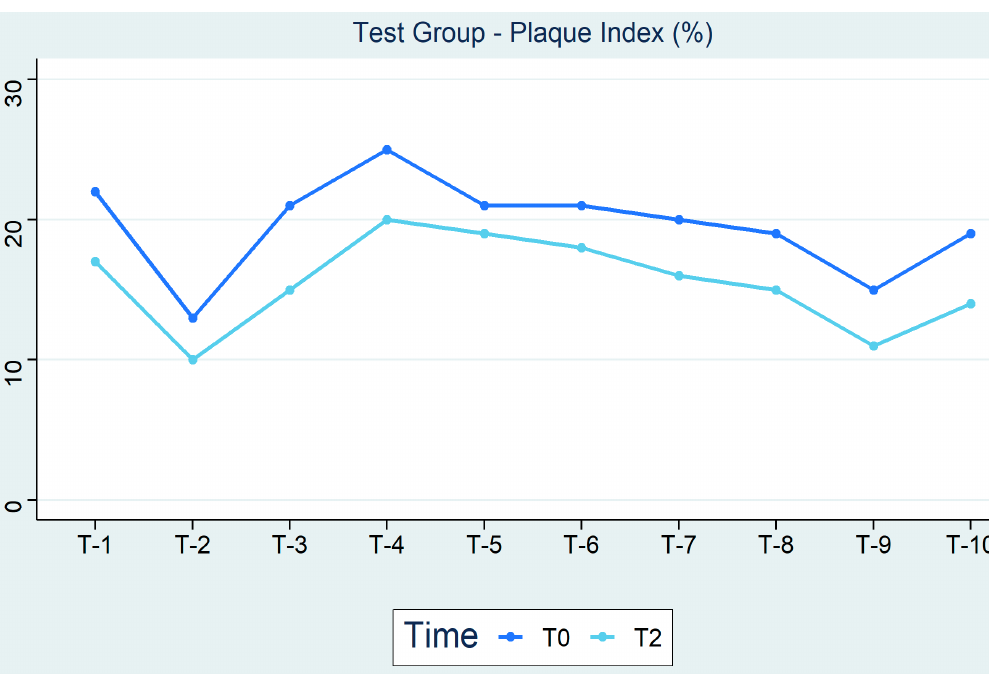
Figure 1. Test Group—Plaque index (%).